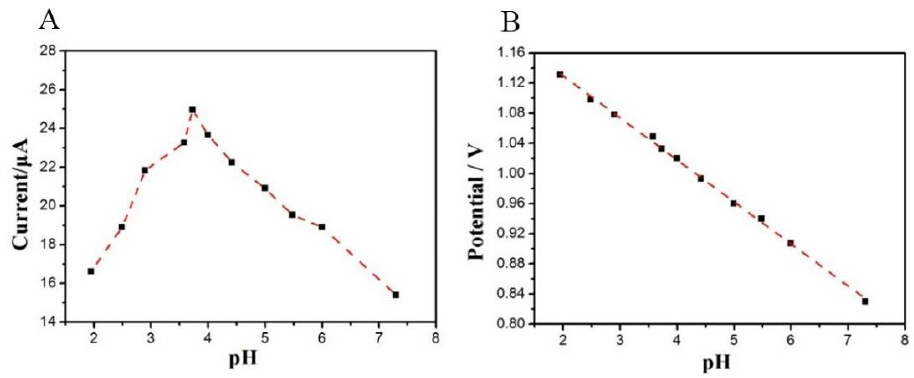
Figure 4. ( A ) Influence of pH on the oxidation peak currents in a 1.0 × 10 −5 mol/L tartrazine solution on the TiO 2 –ErGO–GCE; ( B ) The linear plot of tartrazine oxidation peak potential and pH.